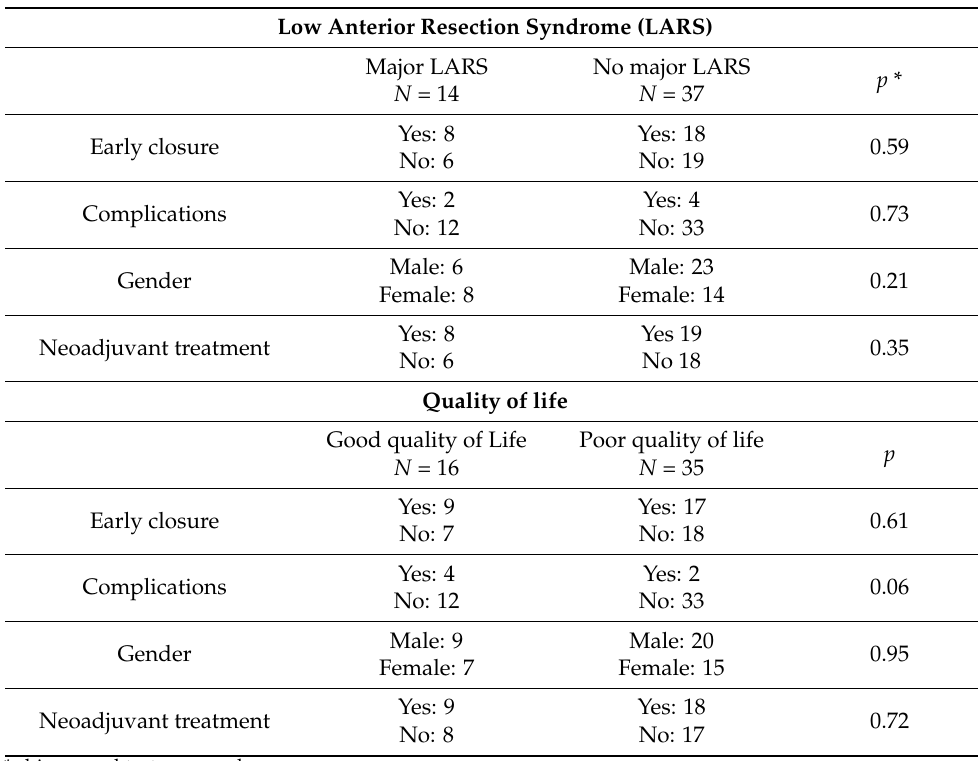
Table 3. Risk factors for worse bowel function and quality of